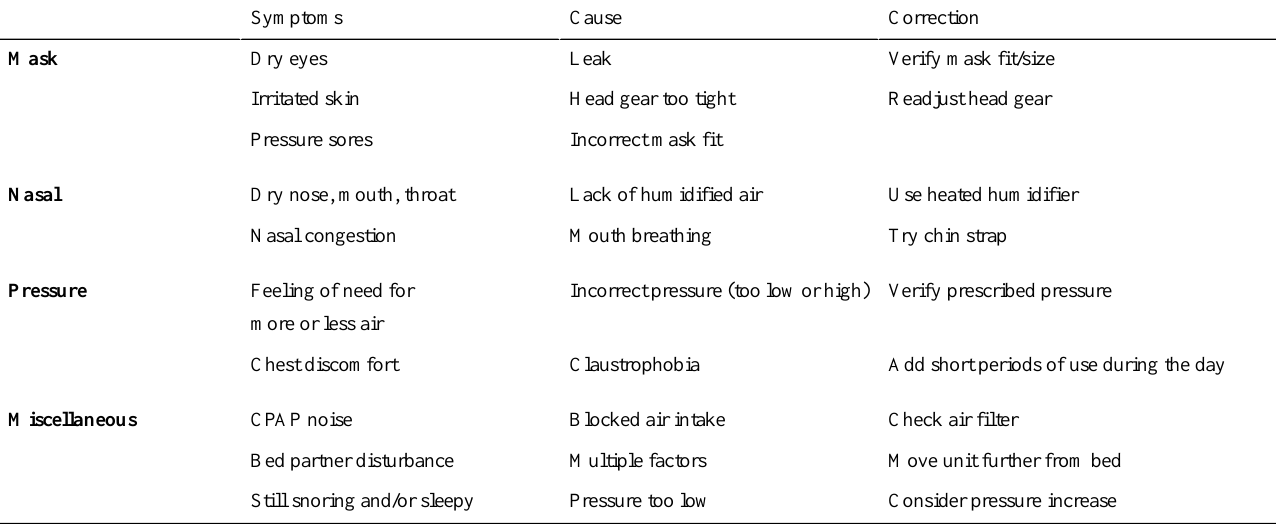
Table 3. CPAP clinician intervention management matrix for TCC group (adapted from [23])